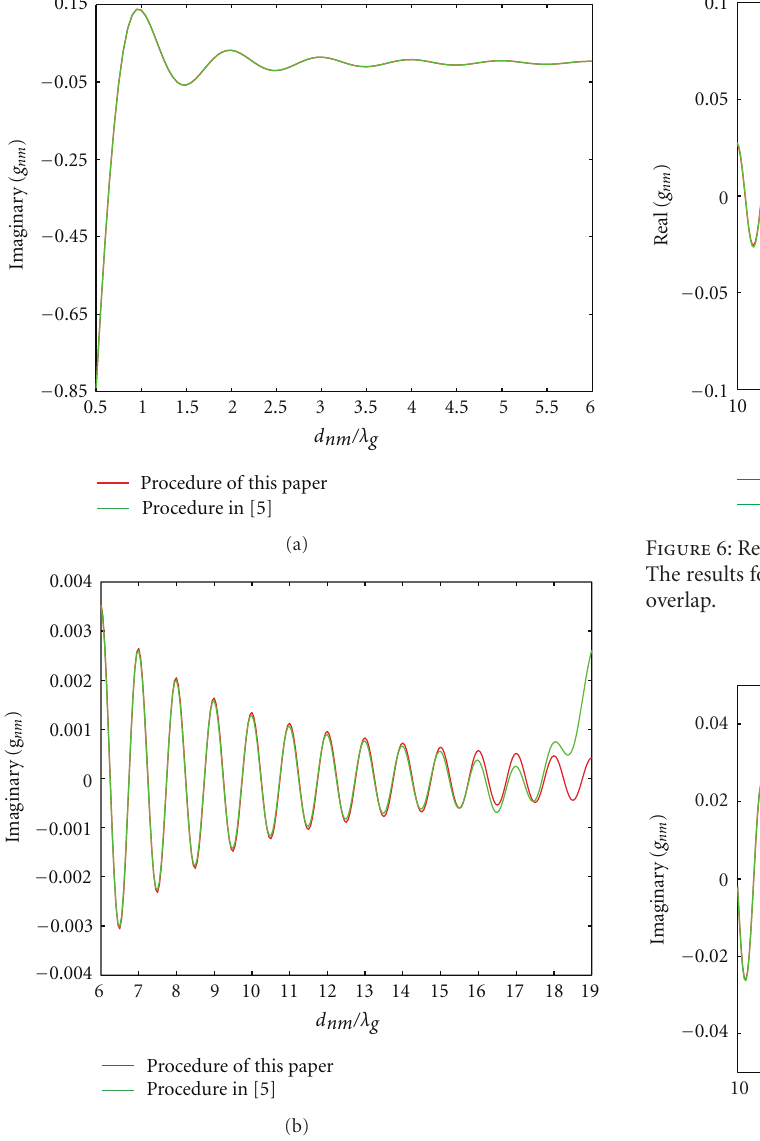
Figure 5: Imaginary part of the mutual coupling coe ffi cient g nm , θ = 0.